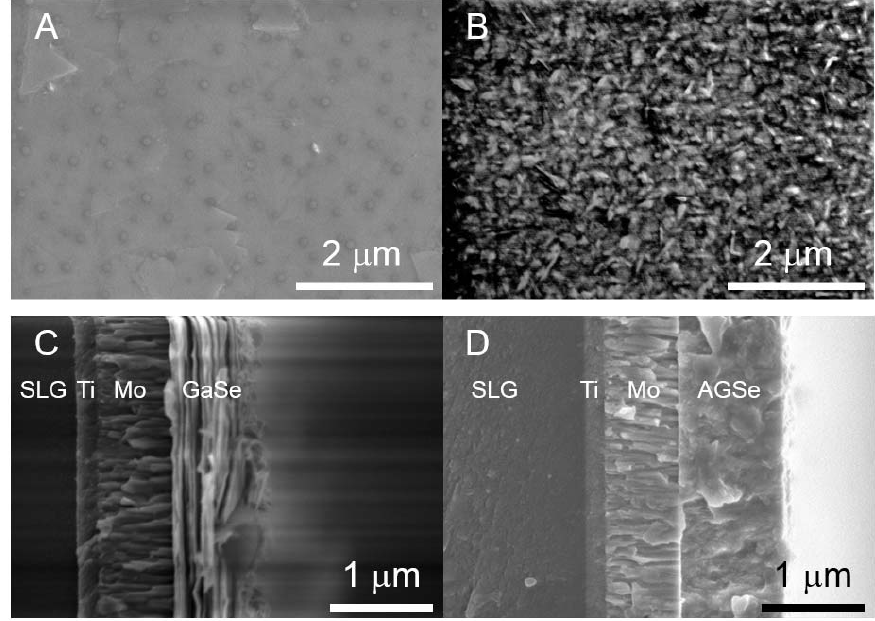
Figure 8. SEM images of a GaSe film ( A , C ) and AGSe (Ag/Ga = 2%) film ( B , D ): plane ( A , B ) and cross-section ( C , D ). An ultrathin CdS layer (not detectable in these images) is deposited on the films for cross-sectional